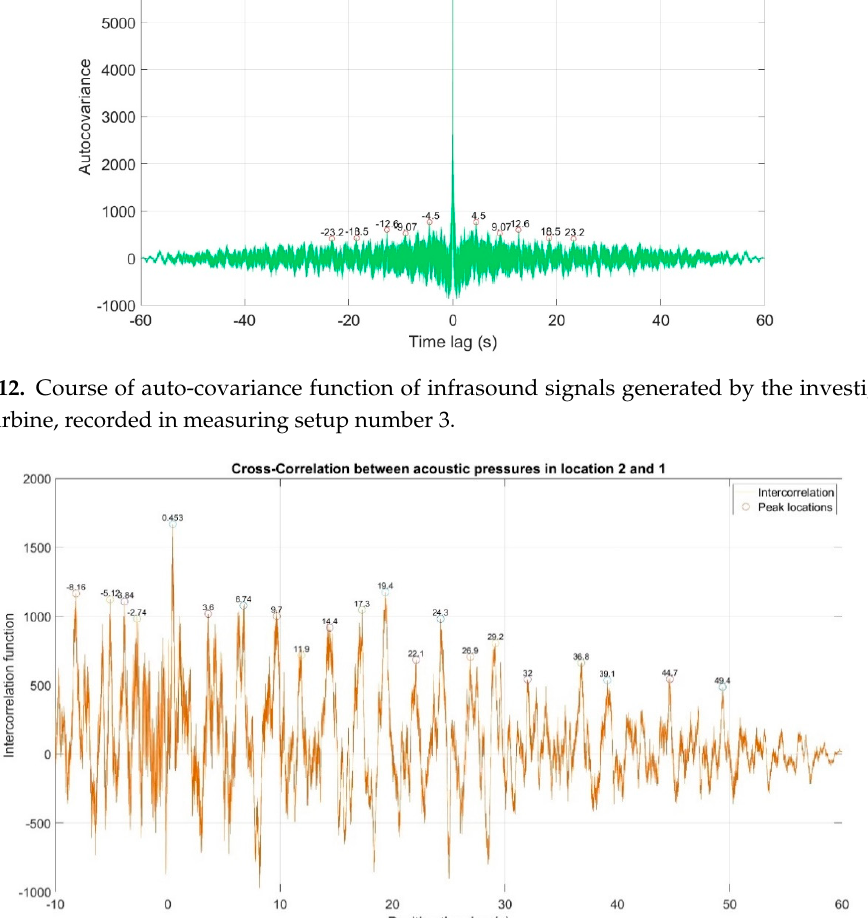
Figure 13. Inter-correlation between acoustic pressures in location 2 and 1. There are several peaks for positive lag. The highest correlation is for lag of 0.45 s.